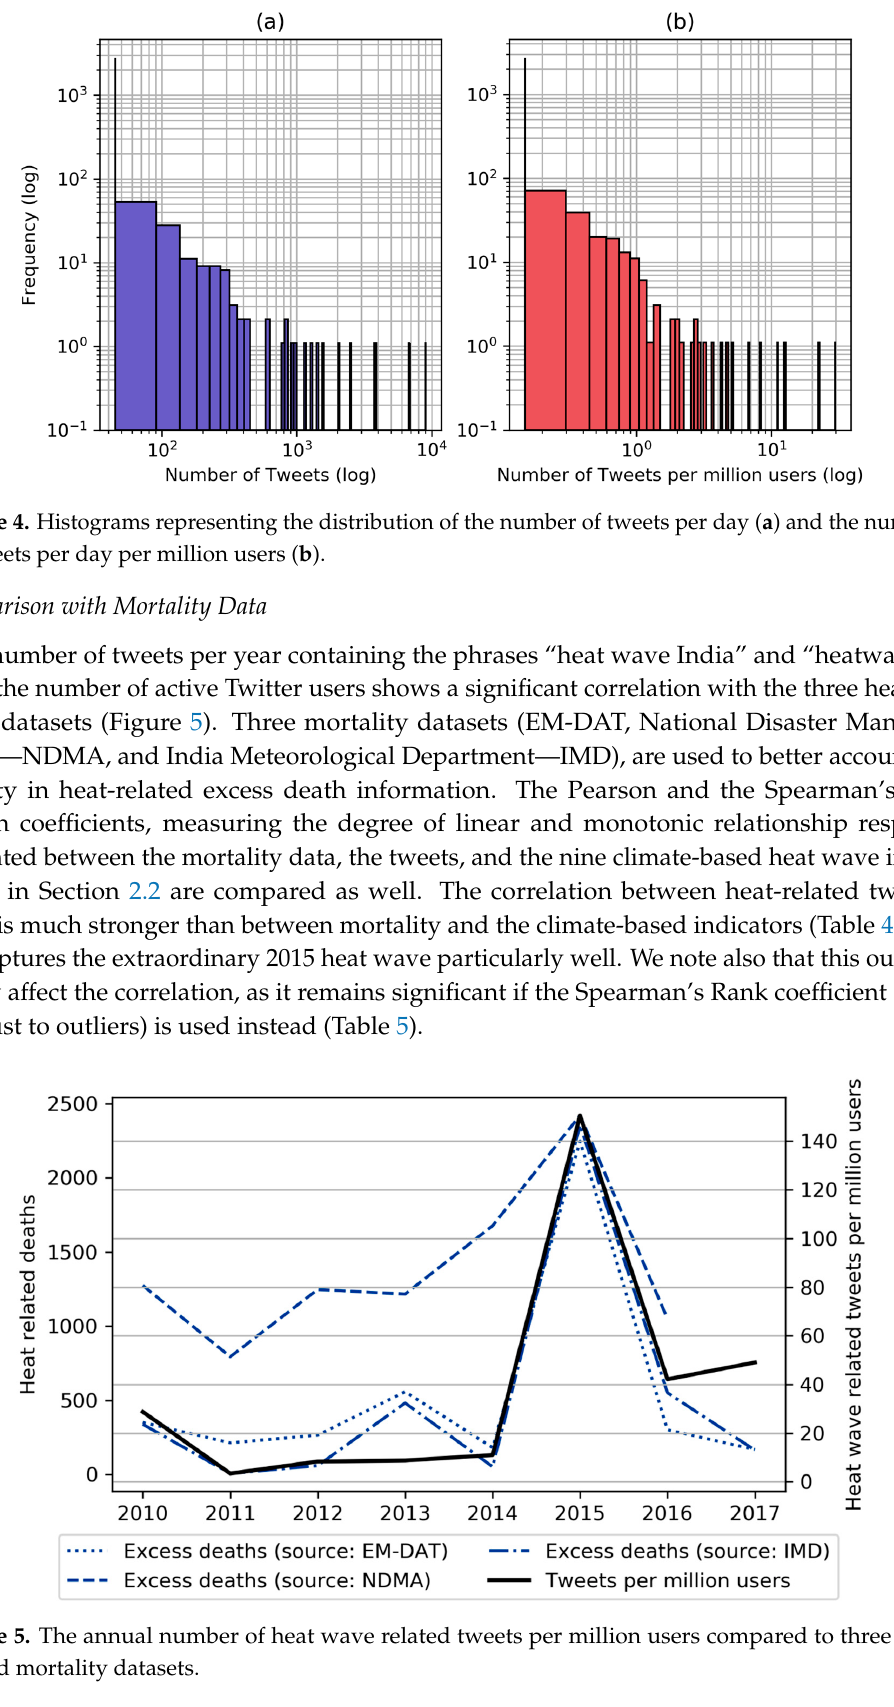
Figure 3. Time series of daily tweets regarding heat waves in India are plotted in panel ( a ) and in panel ( c ) using a logarithmic scale. In panel ( b ) time series of daily tweets are scaled by the number of Twitter users globally and the same time series is plotted in panel ( d ) in logarithmic scale.